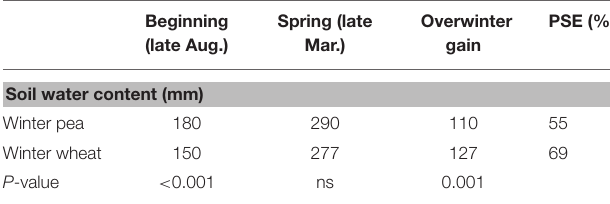
TABLE 2 | (i) Soil water content to a depth of 180 cm measured after harvest of winter pea and winter wheat and again in late March following these two crops; (ii) overwinter gain in soil water, and; (iii) overwinter precipitation storage efficiency in the soil (PSE). Beginning (late Aug.)